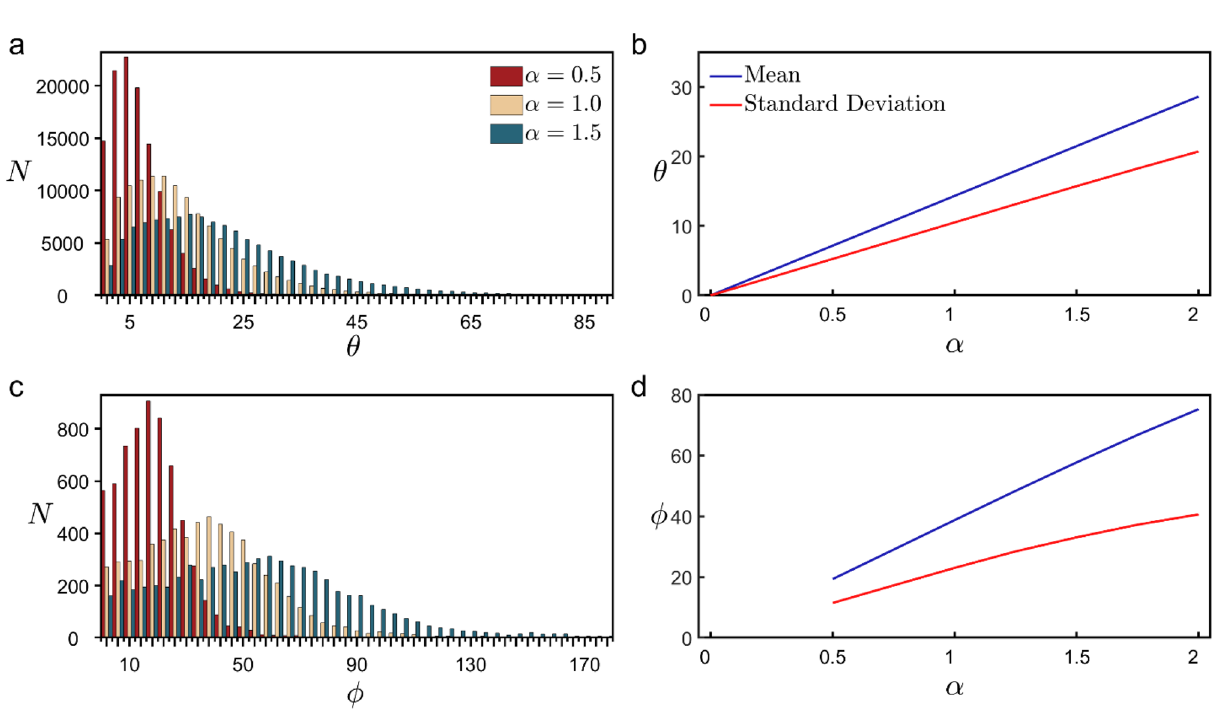
Figure 7. Histograms of the number N of occurrences of weave ( a ) and fork ( c ) angle values across all basal arbors used in the study. The impact of modifying these angles is shown for three α values. ( b , d ) Changes to the peak and breadth of the distribution of these angles as a function of α shown for the range of α that results in physically reasonable model conditions (see Fig. 3 and Supplementary Fig.